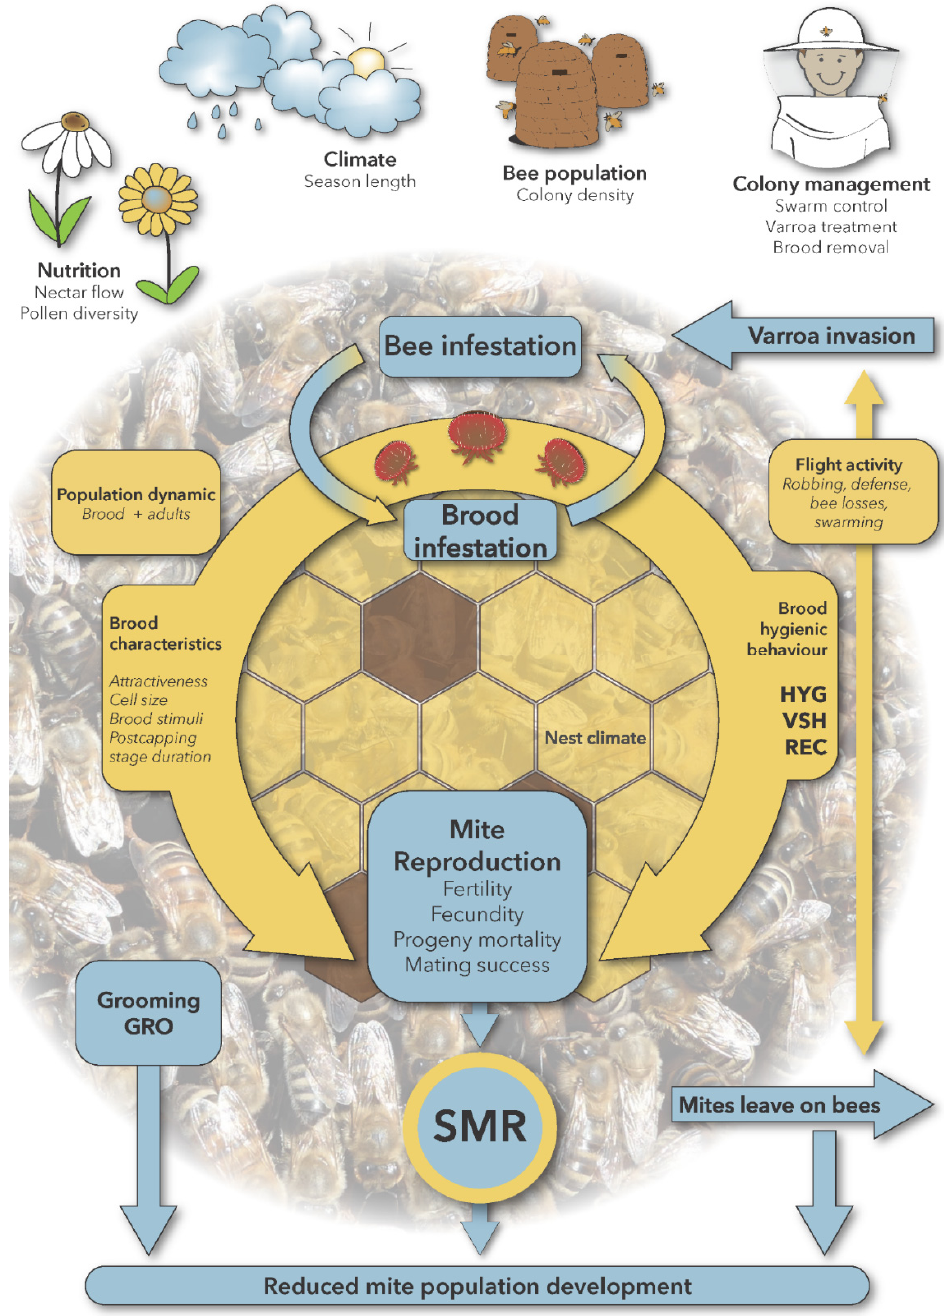
Figure 1. Interactions of mite resistance traits with colony and environmental parameters. Parameters related to the life cycle of the mite are shown in blue (excepted grooming behavior), and characters of the honey bee colony are shown in yellow.